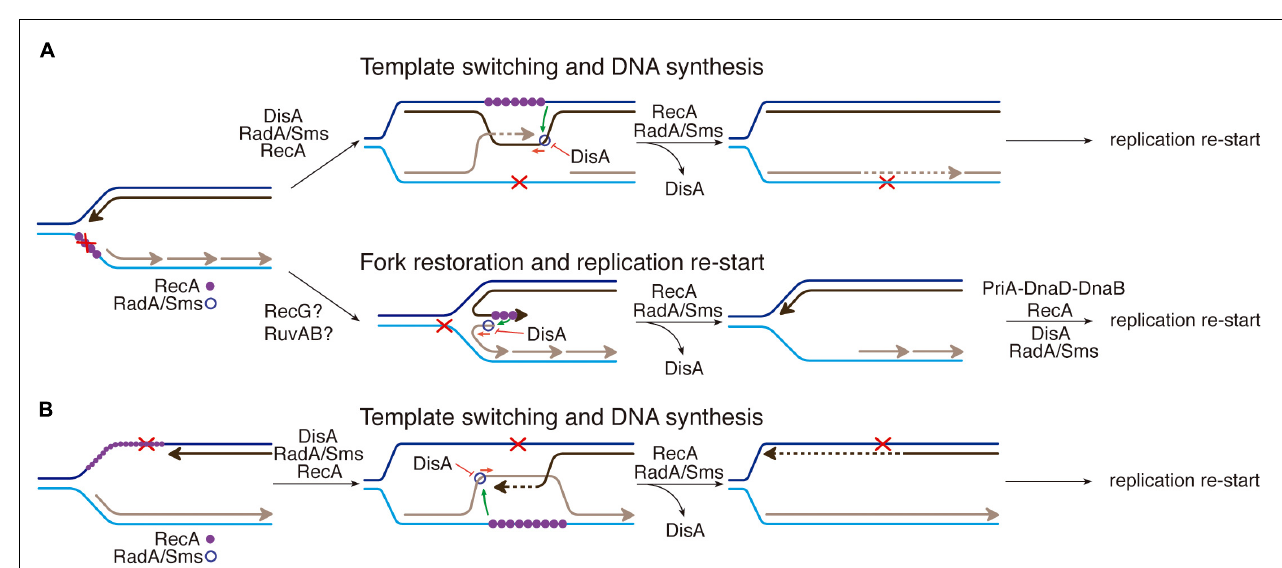
FIGURE 6 | RecA, DisA and RadA/Sms interplay. (A) An unrepaired DNA lesion on the lagging-strand template (red cross) causes blockage of replication fork movement. RecA-bound to the lesion-containing gap suppresses DisA dynamic movement and loads RadA/Sms onto the forked or D-loop structure. (Template switching and DNA synthesis) RecA promotes D-loop formation and RadA/Sms mediates D-loop extension and the invaded strand primes DNA synthesis. DisA bound to D-loop DNA decreases c-di-AMP synthesis, that in turn increases (p)ppGpp synthesis, that inhibits cell proliferation. DisA suppresses RadA/Sms mediated D-loop extension and RecA reloads RadA/Sms in the complementary strand to promote D-loop disassembly. (Fork restoration and replication restart) RadA/Sms unwinds the nascent lagging-strand and allows the fork to be restored. DisA bound to forked DNA decreases c-di-AMP synthesis, that in turn increases (p)ppGpp synthesis, that inhibits cell proliferation. DisA suppresses RadA/Sms mediated DNA unwinding, and DnaD-PriA promote replication re-start. (B) An unrepaired DNA lesion on the leading-strand template (red cross) causes blockage of replication fork movement. RecA-mediated D-loop formation is regulated as depicted in (A) . DisA bound to D-loop or HJ DNA decreases c-di-AMP synthesis, that in turn increases (p)ppGpp synthesis, that inhibits cell proliferation.